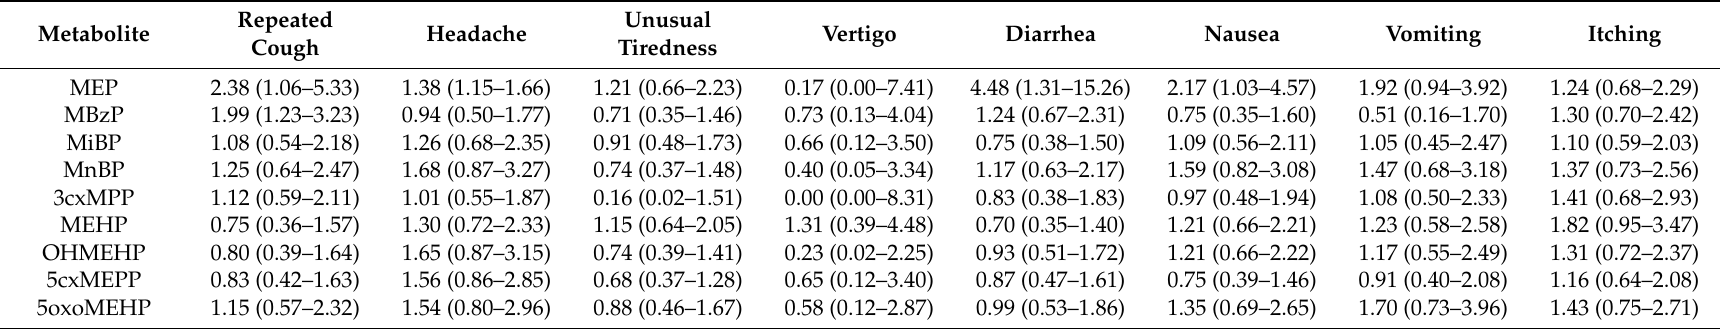
Table 4. Results of logistic regression of symptoms during the last 3 months in children on phthalate metabolites. Odds ratios and 95% confidence intervals for an increase of one standard deviation of the metabolite.